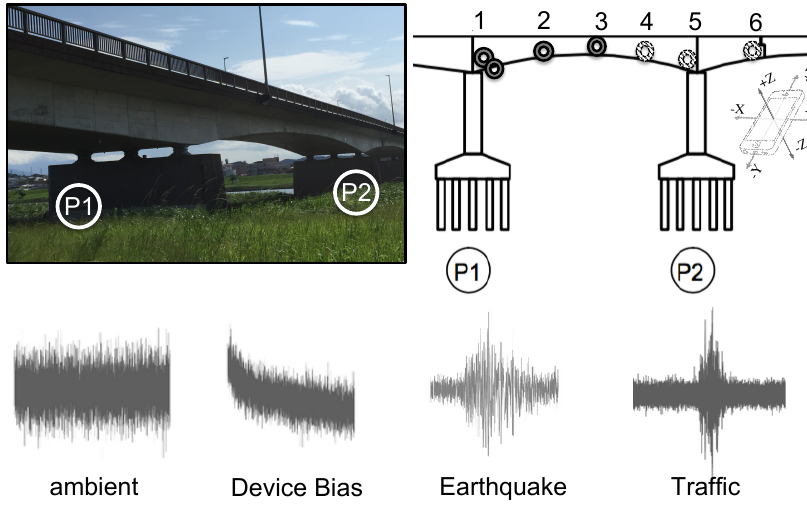
Figure 1. Vibration data measured at the